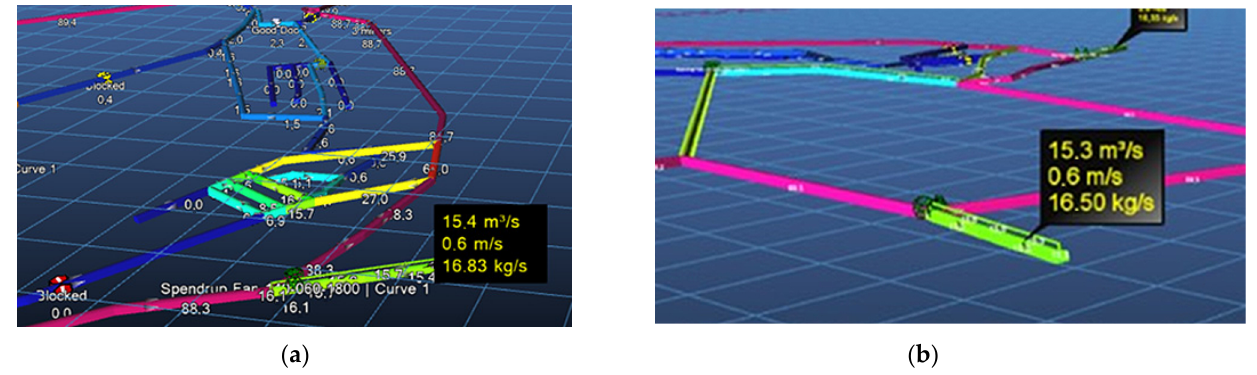
Figure 5. ( a ) Airflow velocity and quantity in working area 1. ( b ) Airflow velocity and quantity in working area 2.